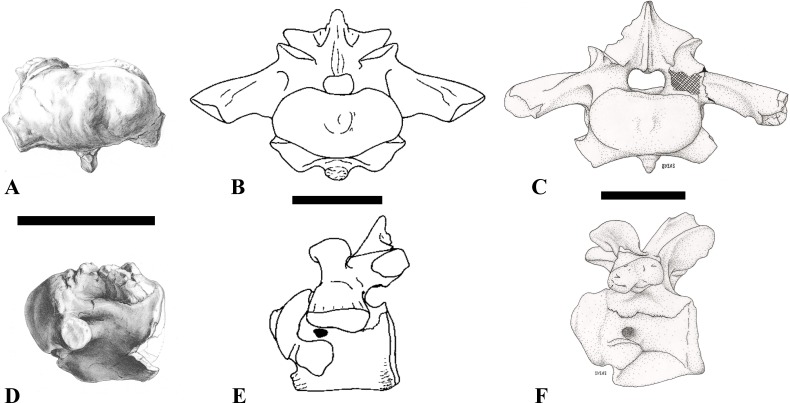
Drawings comparing “Spinosaurus B” and Sigilmassasaurus.(A) “Spinosaurus B” in anterior view; (B) holotype of Sigilmassasaurus brevicollis in anterior view; (C) BSPG 2006 I 54 in anterior view; (D) “Spinosaurus B” in left lateral view; (E) holotype of Sigilmassasaurus brevicollis in left lateral view; (F) BSPG 2006 I 54 in left lateral view. (A, C) modified from Stromer 1934. (B) E re-drawn from Russell (1996). Cross-hatching in (C) represents breakage. Scale bars equal 10 cm.